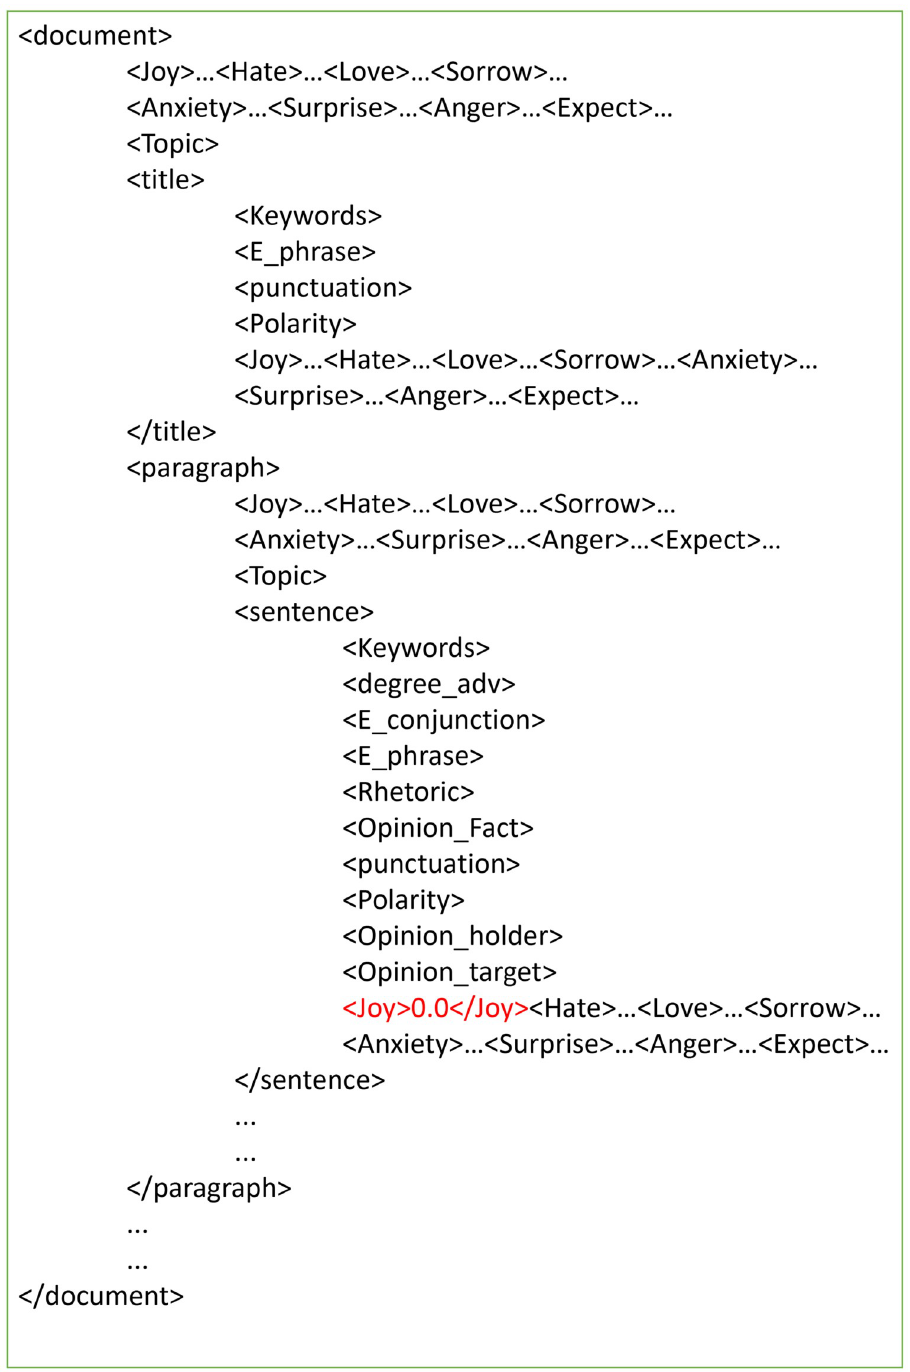
Fig 3. Sample of three-level annotation structure of